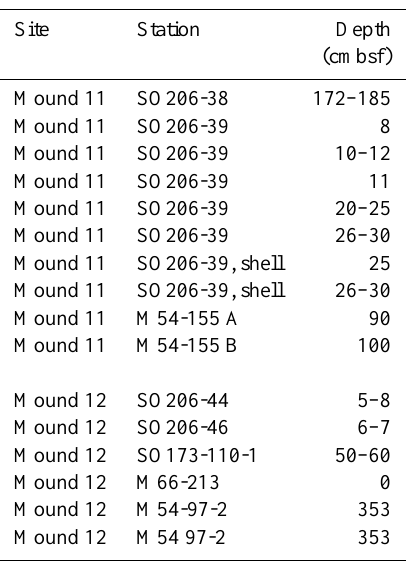
Table 2. List of carbonate samples from Mound 11 and 12 used for mineralogy and stable isotope analysis of carbonates. Samples from SO173, M66, and M54 were used for 87 Sr/ 86 Sr and δ 13 C analysis (cmbsf = centimetres below